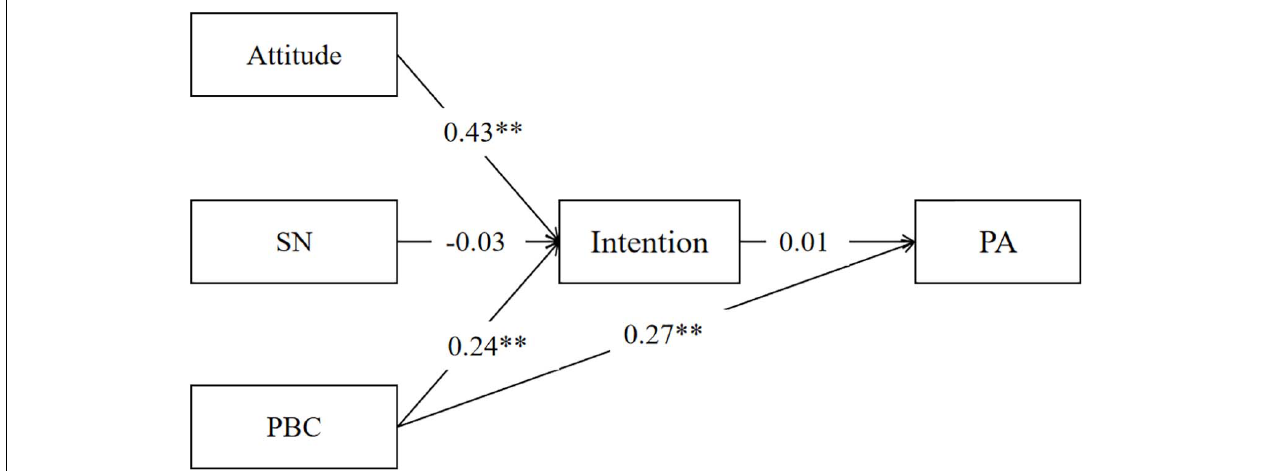
FIGURE 1 | Structural equation model from the TPB constructs to PA among college students. SN, subjective norm; PBC, perceived behavioral control; PA, physical activity; * p < 0.05, ** p < 0.01.